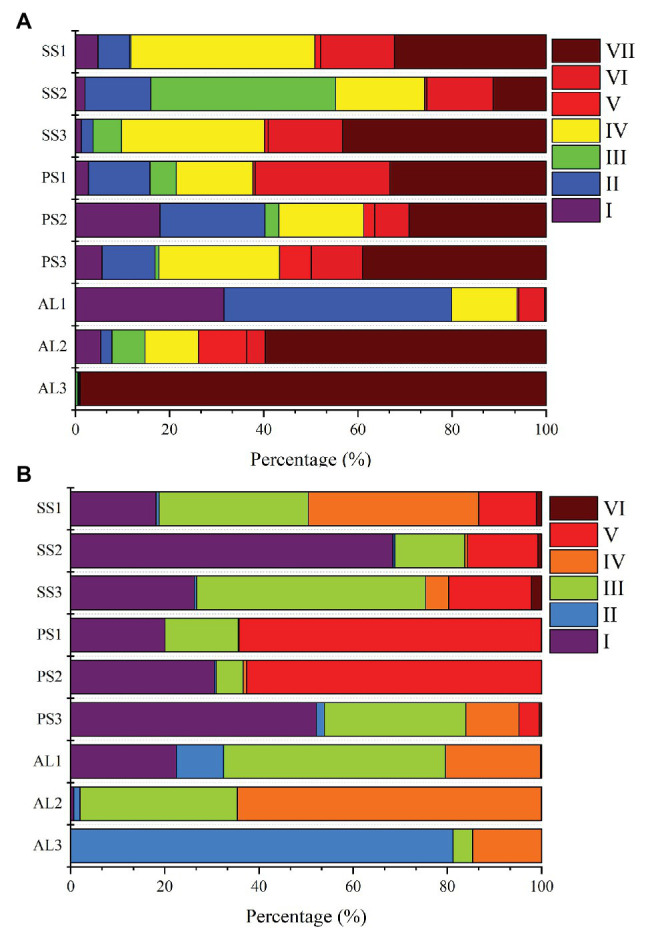
Relative abundances of nirS-encoding (A) and nirK-encoding (B) denitrifiers sequences retrieved from penguin and seal colony soils and animal-lacking tundra soils, as related to different nirS-encoding and nirK-encoding denitrifier clusters. The analysis was based on the most abundant 50 OTUs from different tundra soils of maritime Antarctica.